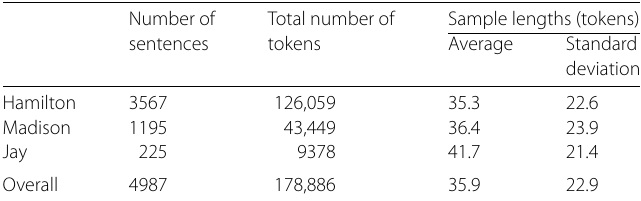
Table 4 Overview of the Federalist Papers Data Set